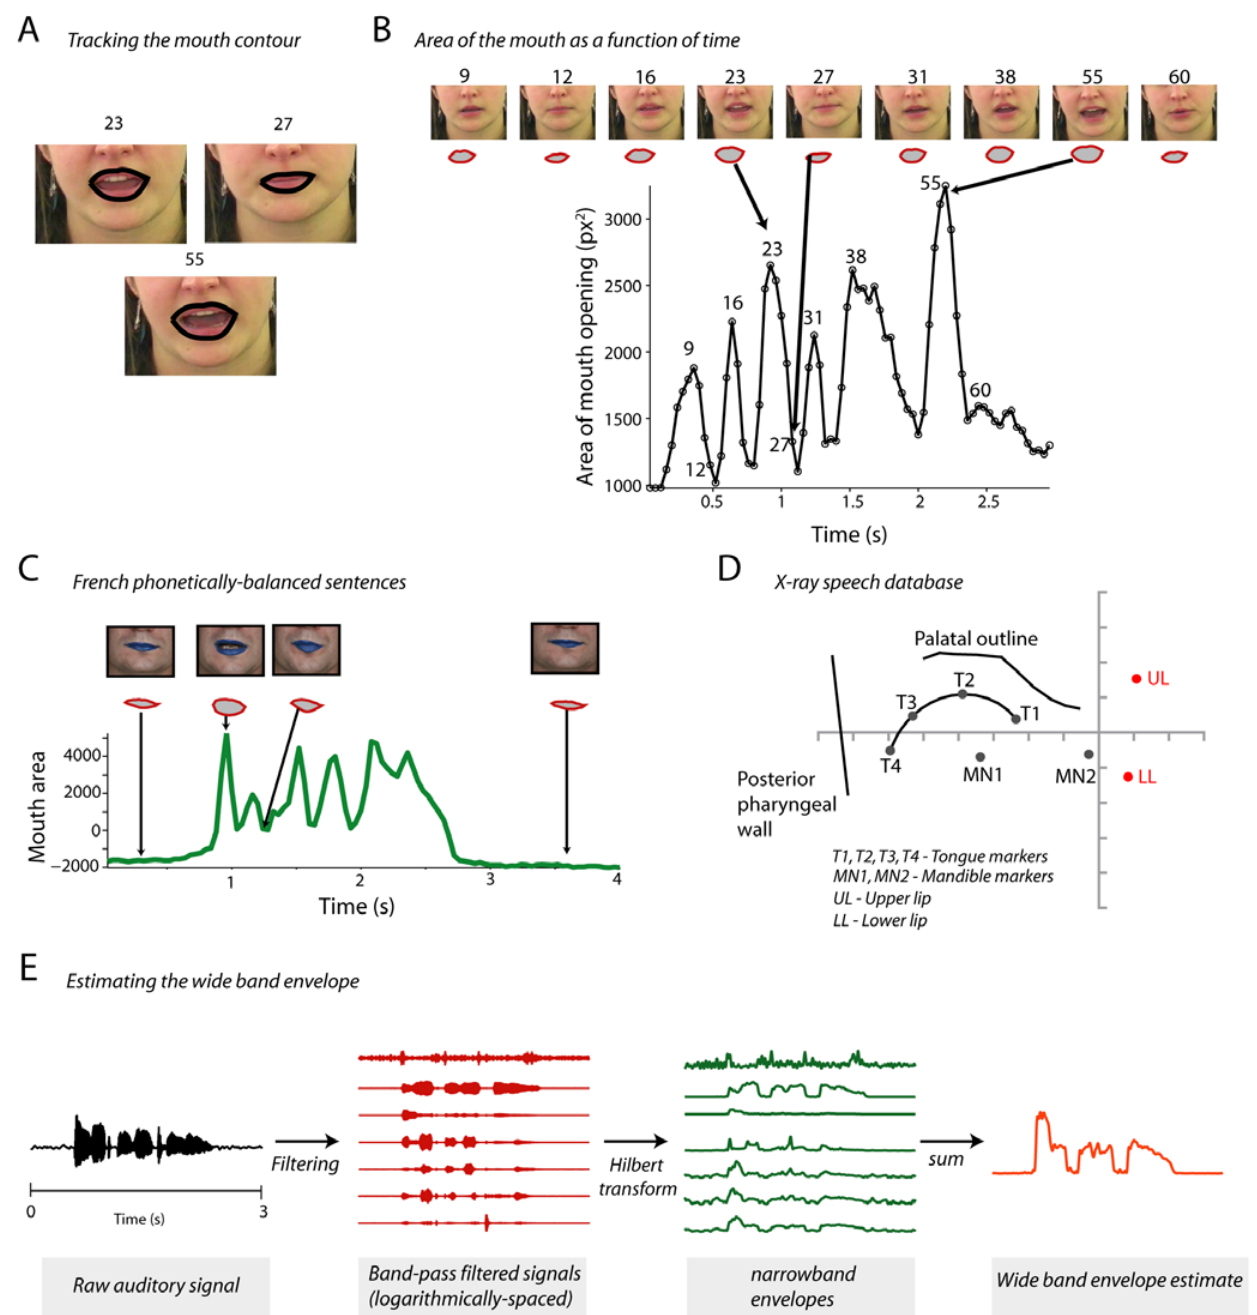
Figure 1. Analysis framework for the visual and auditory components of natural speech. A - Shows the frames from the orofacial region of the mouth for the sentence ‘‘Bin red by y2 now’’ spoken by a single female speaker in the GRID corpus. Black lines denote the fitted lip contour using our contour fitting algorithm (see methods). B - Top panel, shows the frames and the corresponding contours for several frames for the same sentence from the same speaker shown in A. The bottom panel shows the estimated area for each mouth contour as a function of time. X-axes depict time in seconds; y-axes depict the area of the mouth opening in pixel squared. Arrows point to specific frames in the time series depicting different amounts of mouth opening. C - Similar analysis of the French phonetically balanced sentences. Tracking in this case was facilitated by the blue lipstick applied to the lips of the speaker, which allowed for automatic segmentation of the lips from the face. D - A sagittal frame from the x-ray database with the pellet positions marked. Eight different pellets were recorded for this database of human speech. We analyzed the inter-lip distance between the markers UL (upper lip) and LL (lower lip). E - Estimation procedure for the wideband envelope. The signal is first band pass filtered into narrow bands according to a cochlear frequency map. The narrowband envelopes are obtained by taking the Hilbert transform and then computing the absolute value. The wideband envelope is estimated as the sum of the narrowband envelopes.